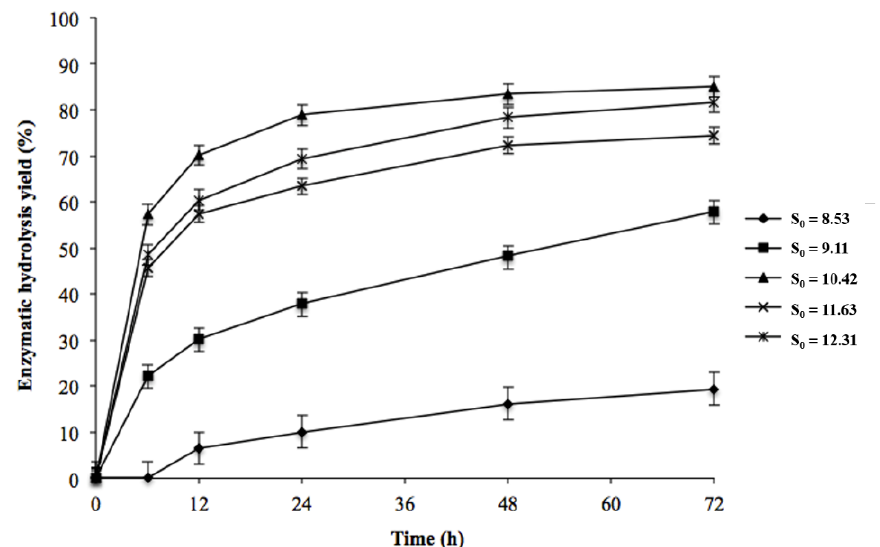
Figure 1. Kinetic profiles of enzymatic hydrolysis of pre-treated solids of E. globulus obtained by steam explosion pre-treatment at different severity factors. The glucans-to-glucose conversion yield is expressed on a dry wood basis. Each sample was performed in triplicate and the error bars correspond to the standard deviation of the repetitions.